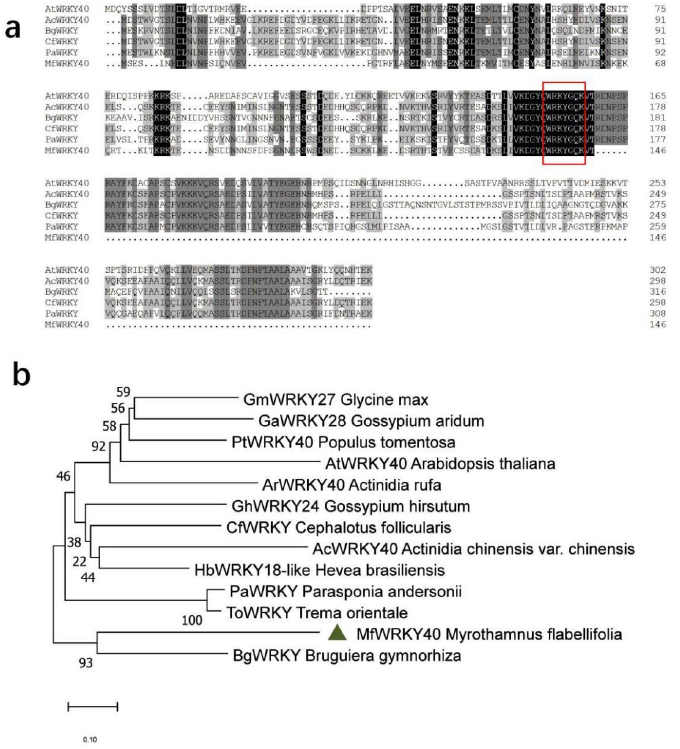
Figure 1. Multiple sequence alignment ( a ) and phylogenetic analysis ( b ) of MfWRKY40 and several highly homologous WRKY proteins. Black and gray shade in ( a ) show identical and similar amino acids, respectively. The WRKY motif was indicated by red box. ( b ) Phylogenetic reconstruction using the neighbor-joining method. The accession numbers for the sequences used were as fol- lows: AtWRKY40 (AT1G80840) of Arabidopsis thaliana ; ArWRKY40 (GFZ11870.1) of Actinidia rufa ; PtWRKY40 (AZQ19202.1) of Populus tomentosa ; GaWRKY28 (AIY62465.1) of Gossypium aridum ; GmWRKY28 (ABC26917.1) of Glycine max ; AcWRKY40 (PSS01081.1) of Actinidia chinensis var. chinensis ; HbWRKY18-like (XP_021659791.1) of Hevea brasiliensis ; GhWRKY24 (AGV75937.1) of Gossypium hirsutum ; CfWRKY (GAV83654.1) of Cephalotus follicularis ; PaWRKY (PON74566.1) of Parasponia andersonii ; ToWRKY (PON99223.1) of Trema orientale ; and BgWRKY (BAG15874.1) of Bruguiera gymnorhiza